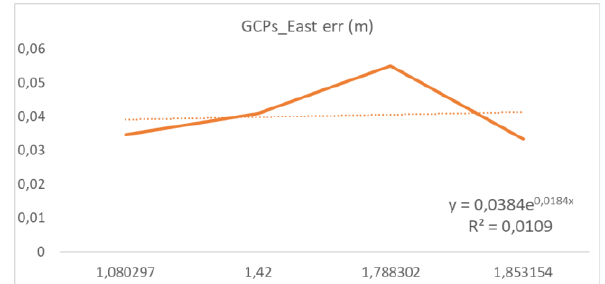
Figure 16. Predictive function extracted through an exponential interpolation between depend (synthetic index) and independent variables (eastern error component). R 2 : coefficient of determination.